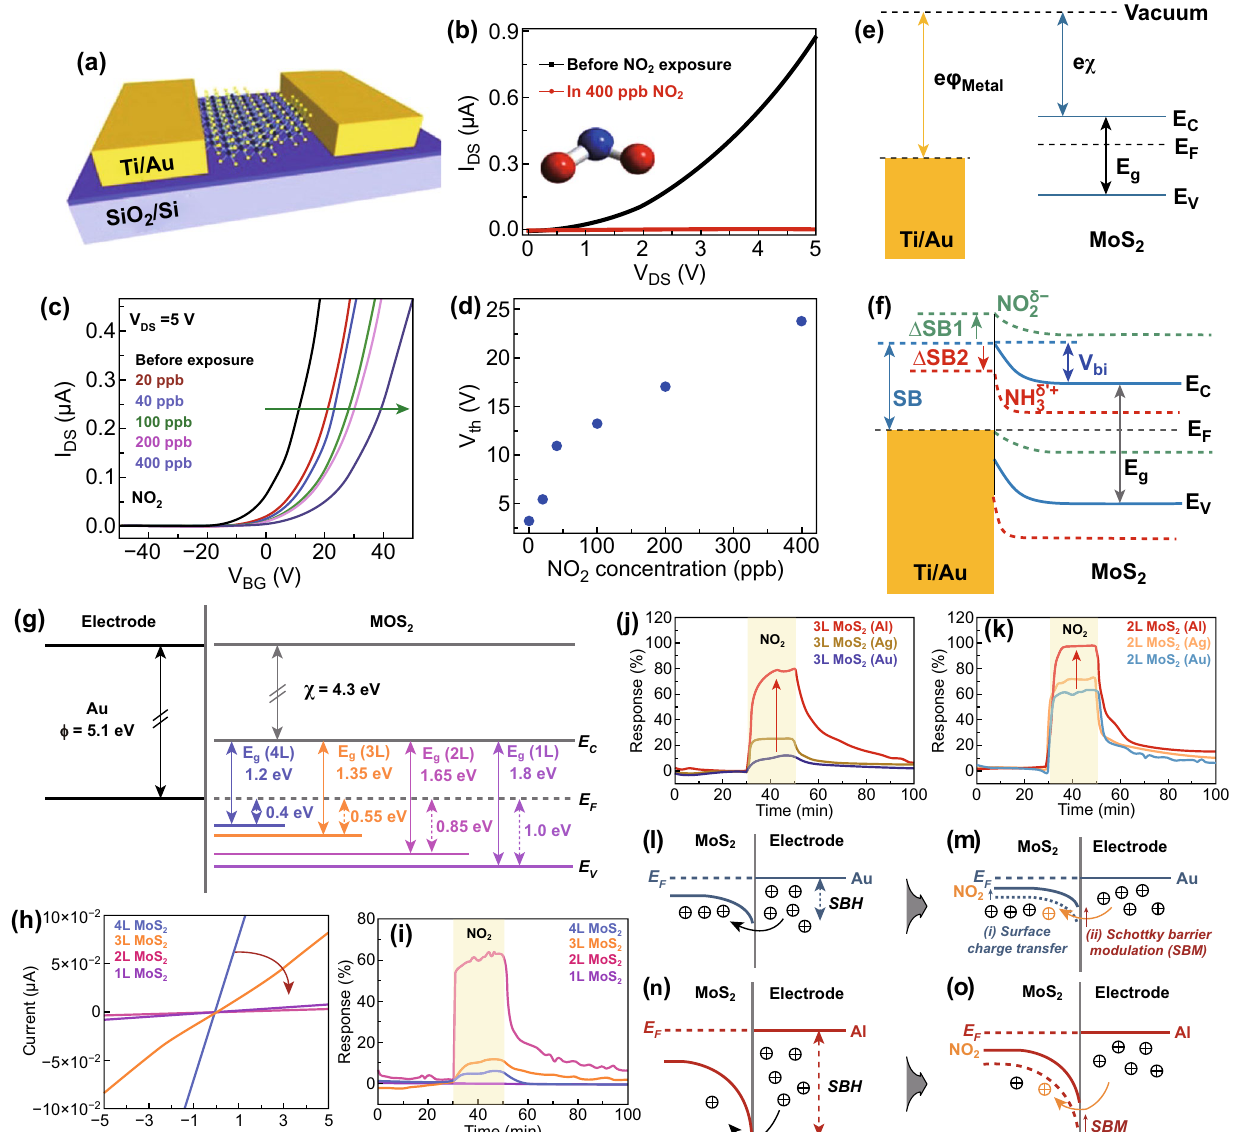
Fig. 11 a Schematic of the monolayer MoS 2 device. b Change in current after 400 ppb NO 2 exposure. c I – V characteristics after the NO 2 expo- sure of different concentration. d A monotonic shift in threshold voltage towards the positive side of applied voltage. e, f Energy band align- ment before and after NO 2 exposure. The blue solid lines are corresponding to the band alignment of MoS 2 and Ti/Au contact in the absence of NO 2 while the green dotted lines are corresponding to NO 2 exposure. Reproduced with permission from Ref. [36]. Copyright (2014) American Chemical Society. g Band alignment of MoS 2 with Au metal contact. h Current versus voltage characteristics with gold contact. i NO 2 response with MOS 2 -Au device. Sensor response for NO 2 with different metal contacts Al, Ag, and Au electrodes: j 3L MoS 2 film, k 2L MoS 2 film. Pro- posed band alignment of MoS 2 -Au device: l before, m after NO 2 exposure. Proposed band alignment of MoS 2 -Al device: n before, o after NO 2 exposure. Reproduced with permission from Ref. [303]. Copyright (2019) American Chemical Society. (Color figure